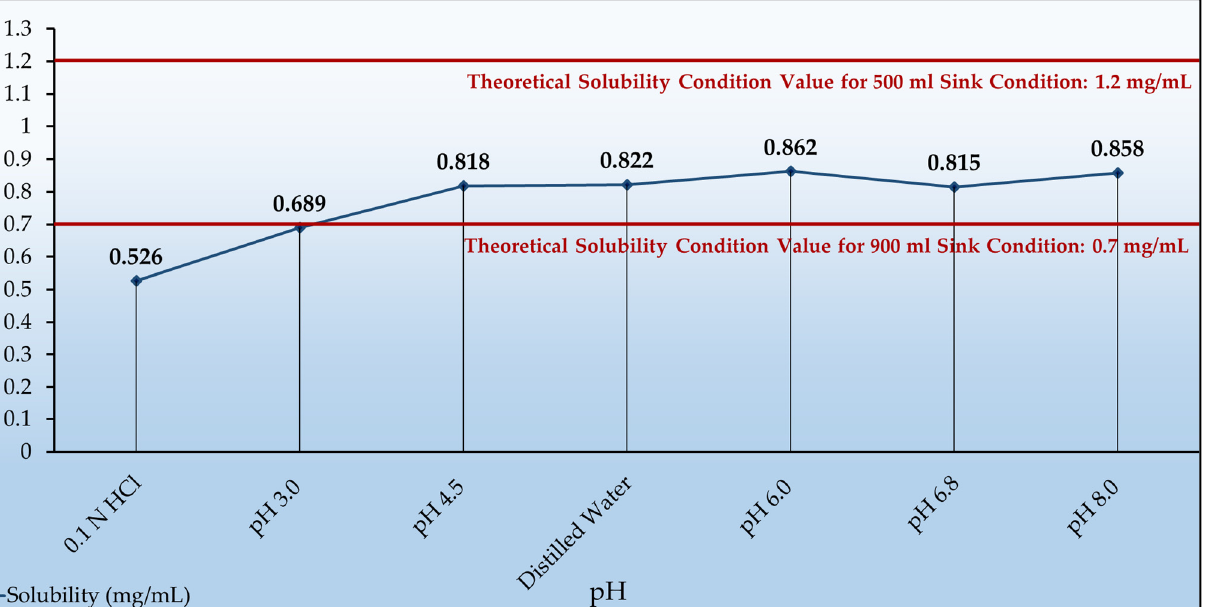
Figure 3. UV-Vis spectrum of favipiravir. The dissolution medium was selected based on the solubility studies. The following dissolution conditions were preferred, and the used analytical method was the UHPLC method. After selecting the best conditions, the validation of the chromatographic method was performed.